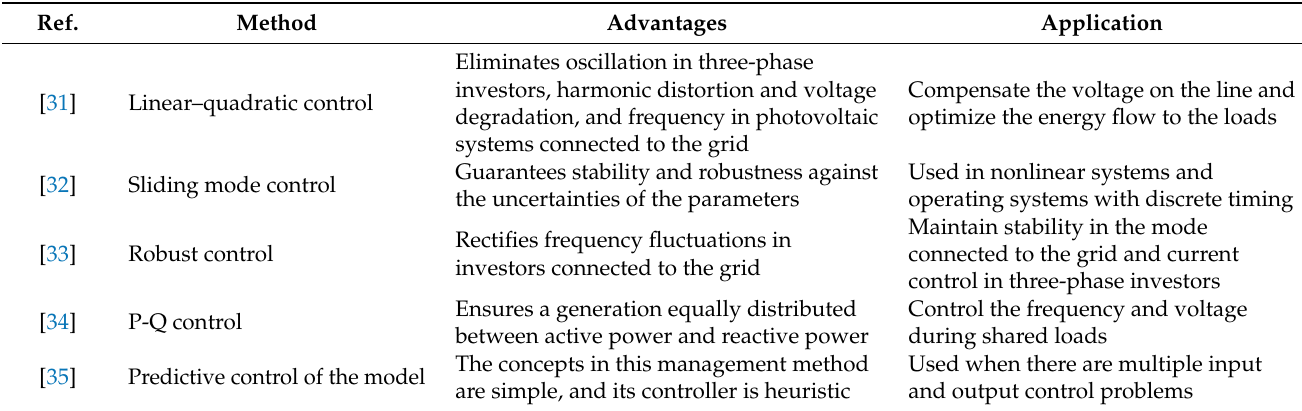
Table 3. Methods of frequency stability.